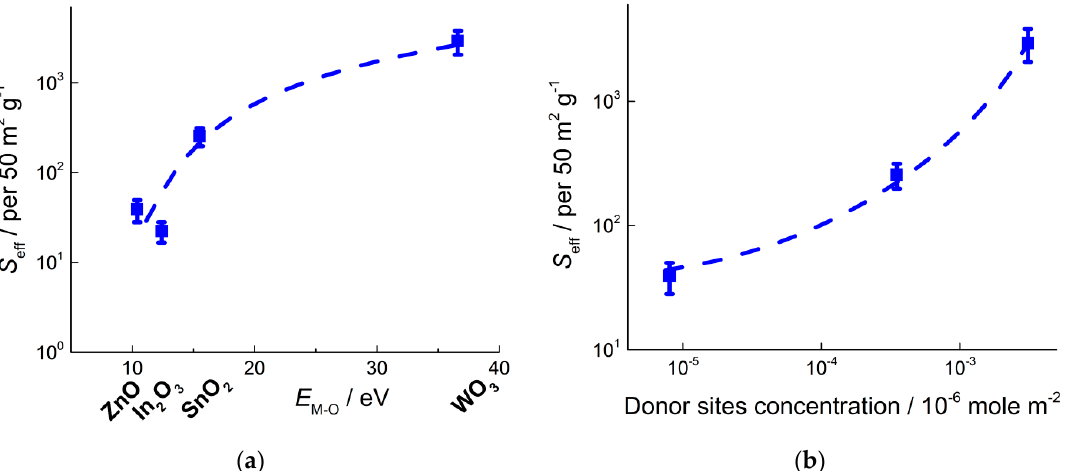
Figure 20. Sensitivity of nanocrystalline n -type MOS to 1 ppm NO 2 at temperature 100–150 °C in relation to metal-oxygen bond energy ( a ) and donor sites concentration ( b ). Adapted with permissions from ref. [42] copyright 2019 by the authors (CC BY); ref. [63] copyright 2021 Elsevier; ref. [102] copyright 2013 Elsevier; ref. [123] copyright 2015 by the authors (CC BY).